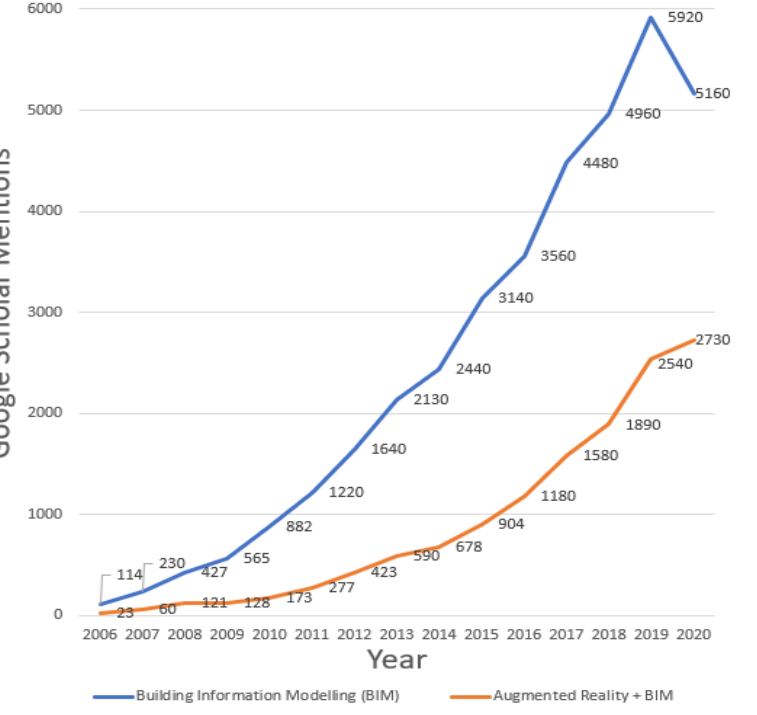
Figure 1. The growth of BIM and BIM + AR based on the yearly Google Scholar article mentions (patents and citations excluded). The following query terms were used: BIM—(“Building Information Modeling” OR "Building Information Modelling”), BIM + AR—(“Building Information Modeling” OR “Building Information Modelling”), AND (“Augmented Reality” OR “AR” OR “Mixed